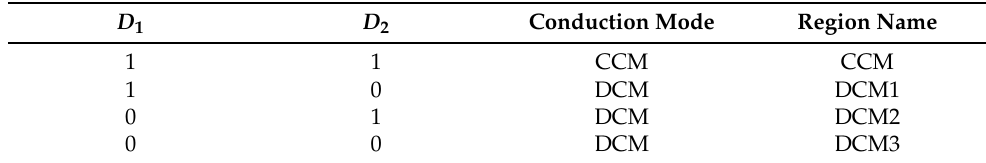
Figure 2. ( a ) SEPIC converter modified with an additional diode at the input port, ( b ) equivalent circuit when the transistor is OFF. Table 1. Conduction modes for the modified SEPIC